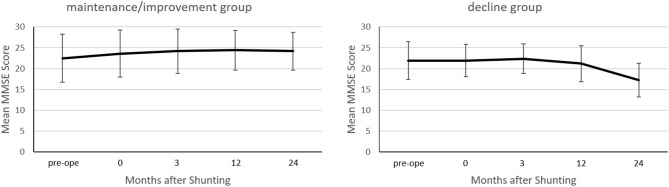
Between-group comparison of the mean Mini-Mental State Examination (MMSE) score before and after shunting. In the maintenance/improvement group, the mean MMSE score improved at 24 months post-operatively compared to preoperatively (p < 0.0001). Conversely, in the decline group, the mean MMSE score declined at 24 months post-/operatively compared to preoperatively (p = 0.0002). Changes in the MMSE score were assessed using Wilcoxon's signed-rank test.